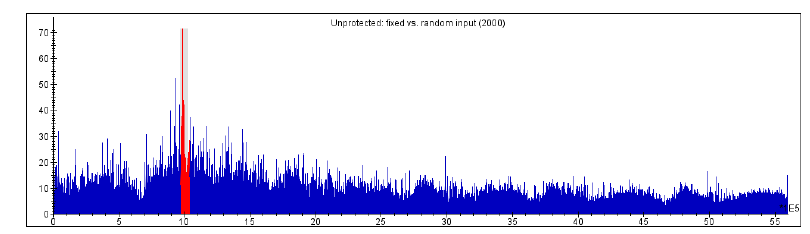
Figure 1: Unprotected imp. TVLA: fixed vs random point. Alignment is marked red.